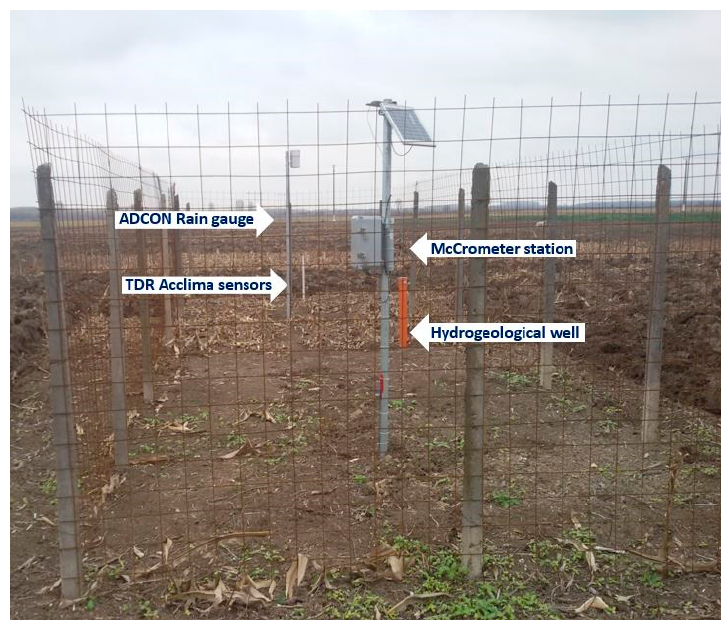
Figure 4. McCrometer Connect Mini ‐ Sat Field Monitoring Station equipped with rain gage, soil sensors, water level sensor and satellite antenna.